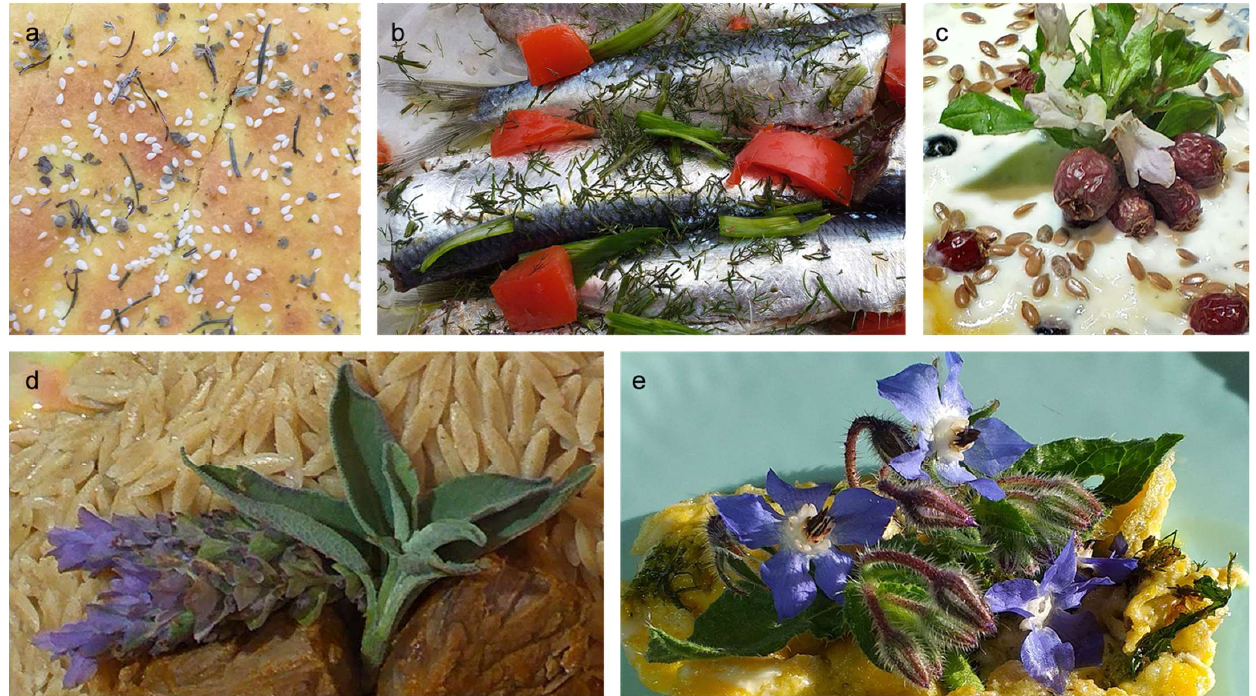
Figure 5. Examples of Mediterranean plants used in culinary products. ( a ) Dried Origanum onites L. and Rosmarinus officinalis L. leaves on bread crust, ( b ) fresh Foeniculum vulgare Hill. leaves on sardines, ( c ) Crataegus monogyna on cheese spread, ( d ) Salvia fruticosa Mill. on stew, ( e ) Borago officinalis L. in omelet. Photos: I. Christoforidi.